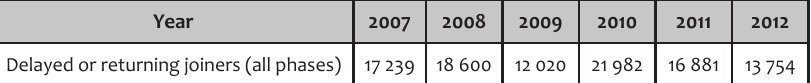
Table 4: Delayed or returning joiners, 2007–2012 (Source: PERSAL